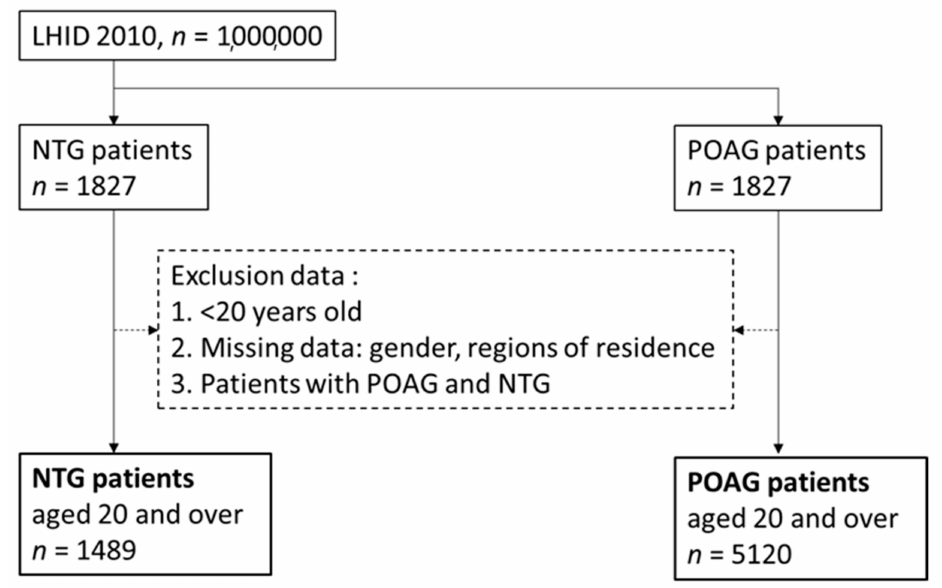
Figure 1. Study flowchart of NTG and POAG. NTG: normal-tension glaucoma; POAG: primary open-angle